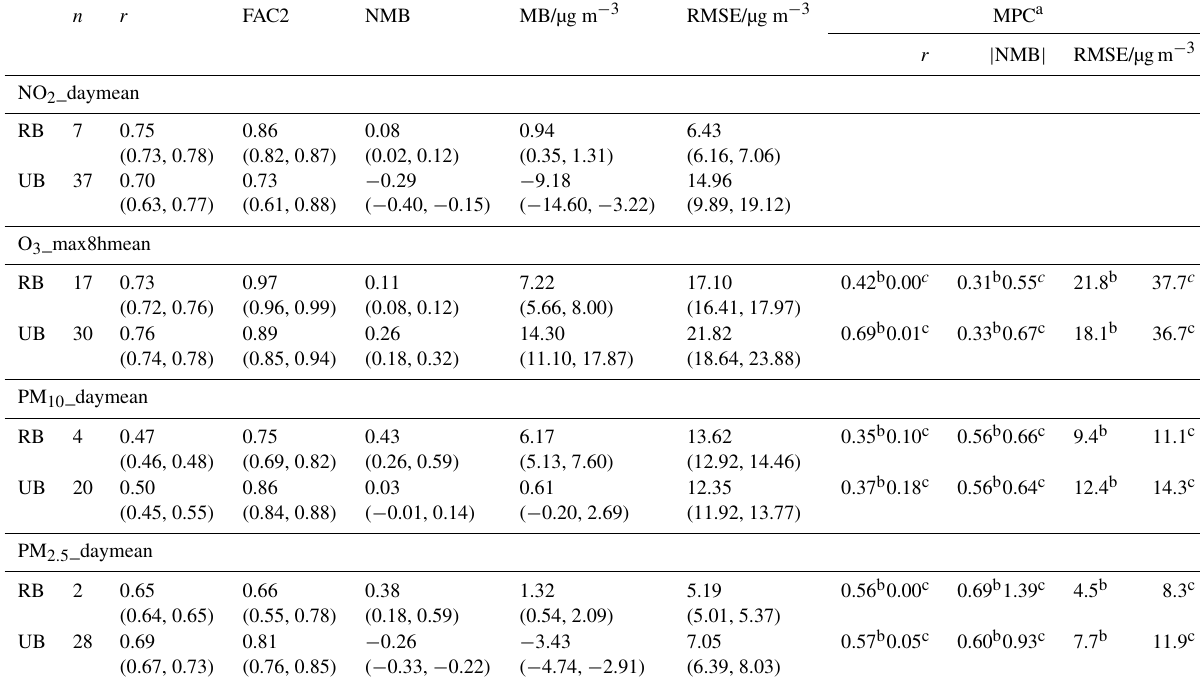
Table 3. Median (25th percentile, 75th percentile) values of the n individual-site model–measurement statistics of daily pollutant metric for the full 10-year period (2-year period for PM 2 . 5 ) , grouped by site type: RB, rural background; UB, urban background. Also shown are indicative minimum values for r , and maximum values for | NMB | and RMSE that satisfy model performance criteria (MPC) allowing for uncertainty in the measurement. See footnotes and main text for further